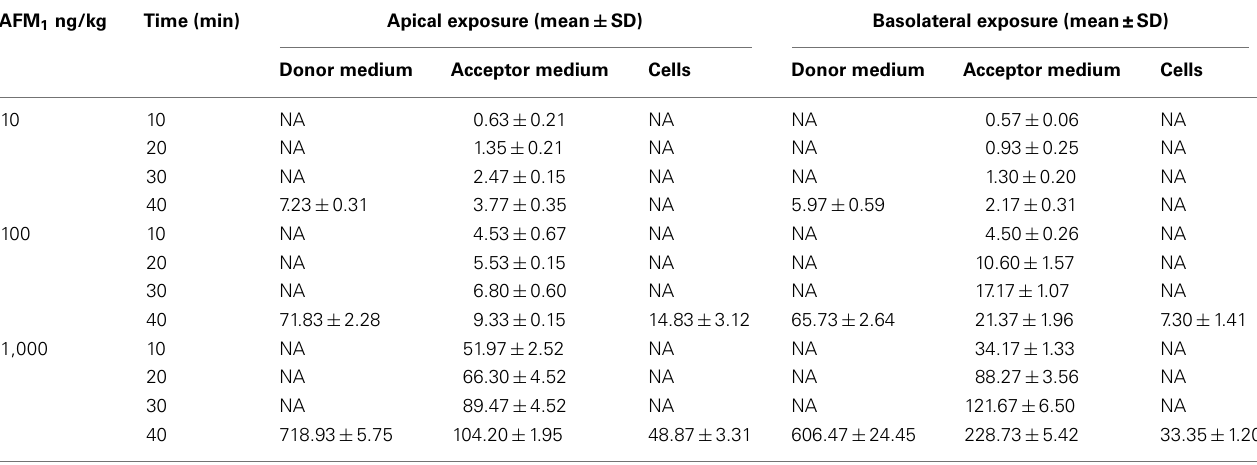
Table 2 |AFM 1 detection in donor compartment, acceptor compartment, and cellular fractions after exposure for 40min. AFM 1